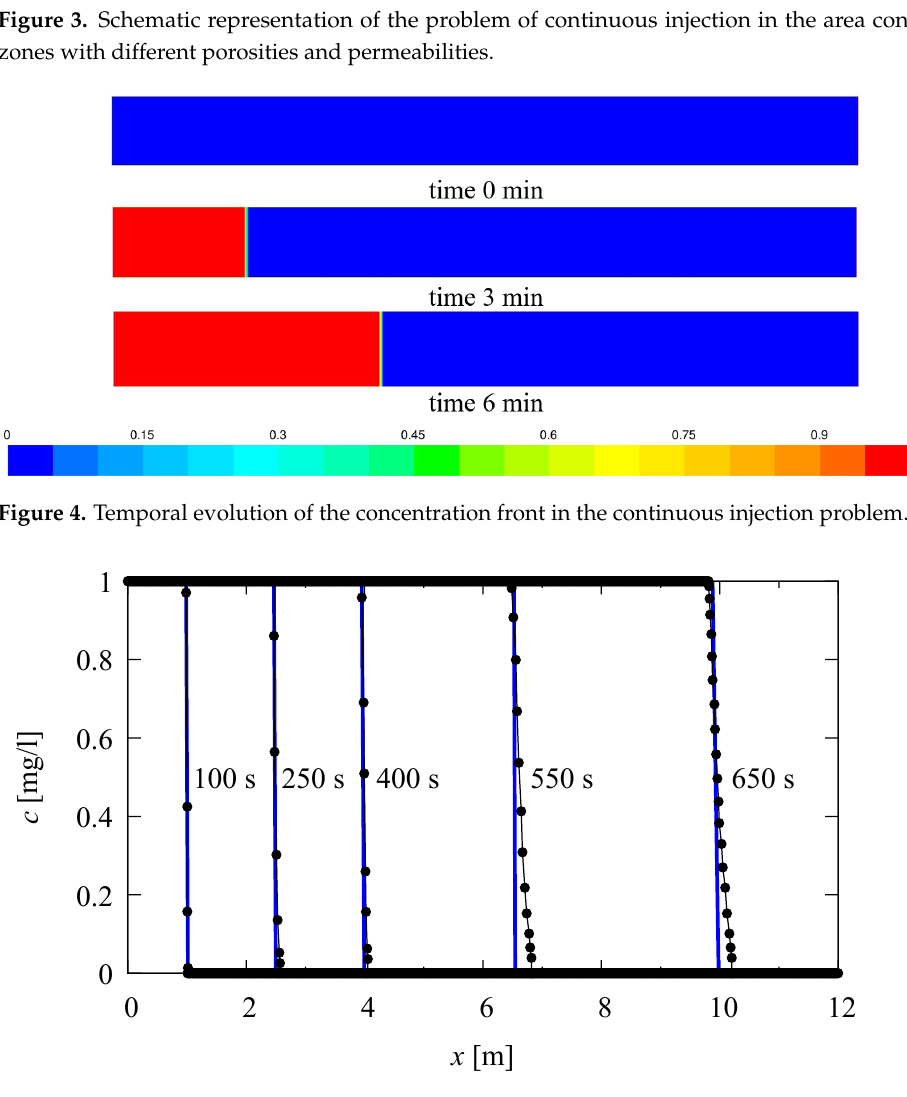
Figure 5. Comparison between simulated (points) and analytically calculated concentrations (lines) found in [74] under conditions of constant